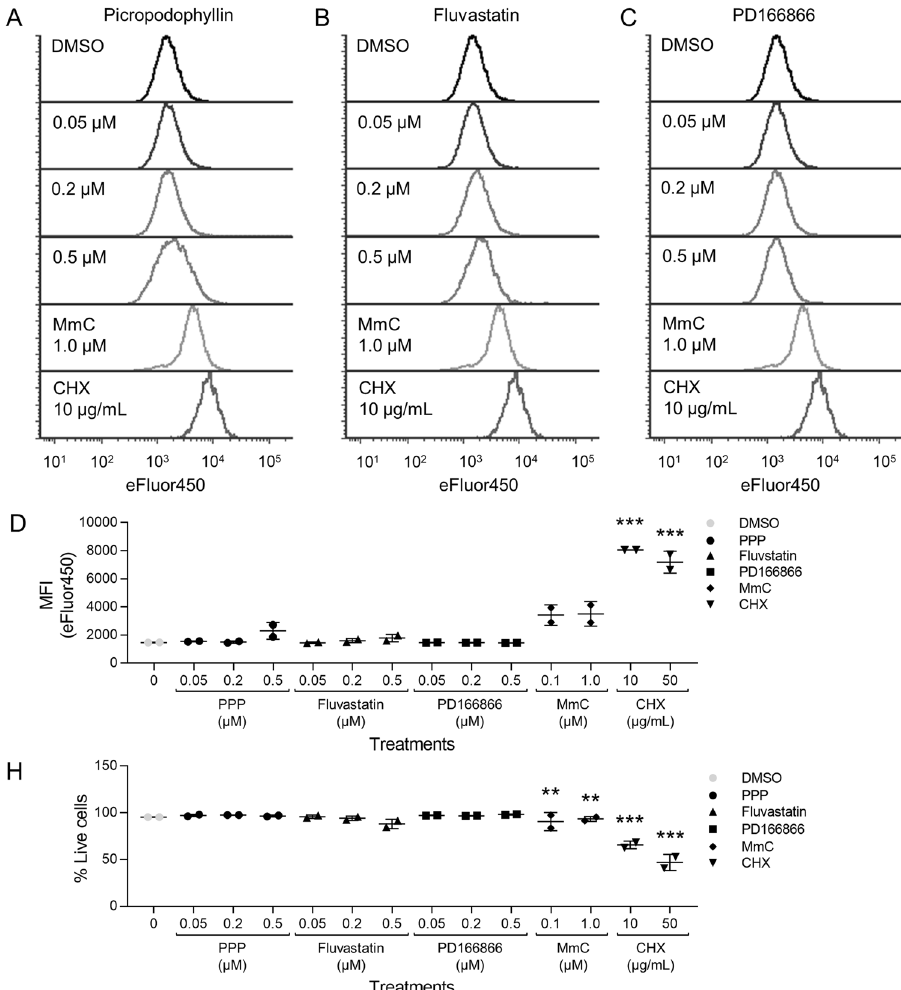
Figure 3. PPP, fluvastatin or PD166866 do not inhibit 2D proliferation of JB6 P + cells. Histograms of JB6 P + cells stained with Cell Proliferation Dye eFluor ™ 450 were treated with ( A ) PPP, ( B ) fluvastatin, PD166866 ( C ) or the vehicle, DMSO. Inhibition of proliferation is indicated by higher fluorescent signal that is represented by visually distinct rightward shifted histograms as shown following treatment with mitomycin C (MmC) and cycloheximide (CHX). The same histograms for DMSO, MmC (1.0 µ M), and CHX (10 µ g/mL) are shown for comparison with PPP, fluvastatin, and PD166866. ( D ) The eFluor ™ 450 MFI of JB6 P + cells (singlet, SYTOX Red negative cells) stained with Cell Proliferation eFluor ™ 450 and treated with PPP, fluvastatin, or PD166866 was graphically depicted. PPP, fluvastatin, and PD166866 did not significantly influence the eFluor ™ 450 MFI compared to vehicle (DMSO) controls, whereas MMC and CHX (positive controls) had significantly higher eFluor ™ 450 MFI values. ( E ) PPP, fluvastatin, or PD166866 did not significantly decrease the % of live cells (singlet, SYTOX Red negative cells). MmC and CHX significantly induced cell death at 0.1 and 1.0 µ M and 10 and 50 µ g/mL respectively. Each treatment group had two replicates and analyzed by one-way ANOVA with multiple comparisons ( ** p < 0.01; *** p <